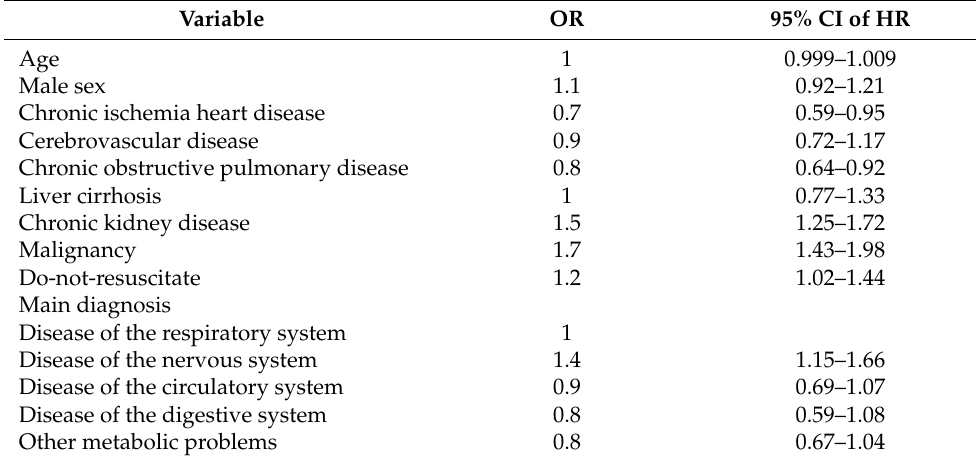
Table 4. Predicotors of prolonged hospital length of stay in survival